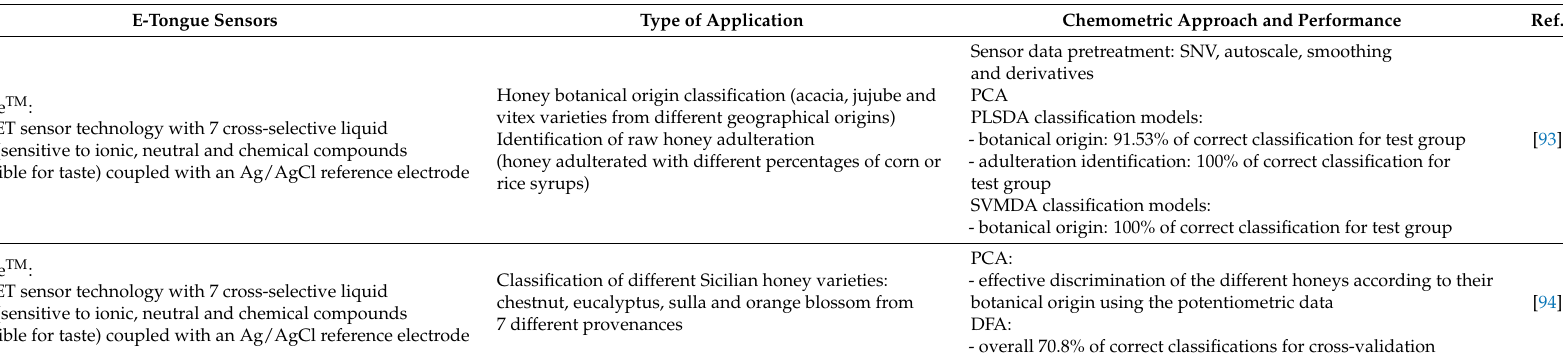
test group SVMDA classification models: - botanical origin: 100% of correct classification for test group